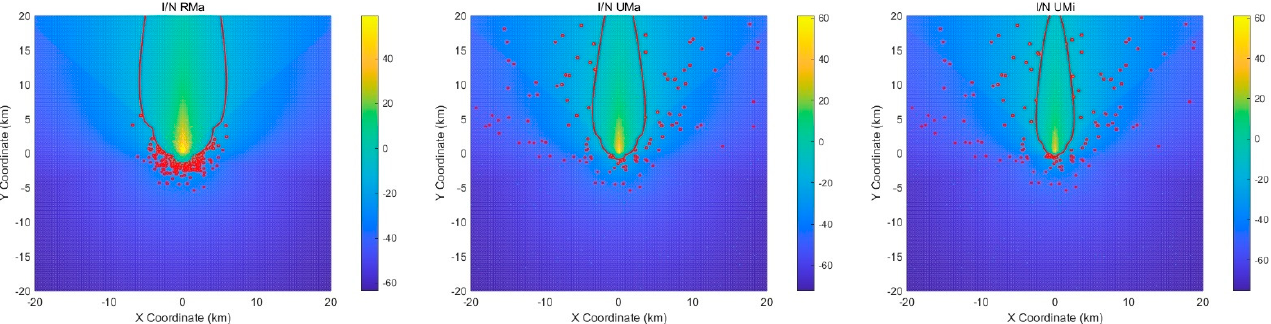
Figure 14. RMa, UMa, and UMi scenario with an ES antenna elevation angle of 5° for a 4 × 4 beamforming antenna array.